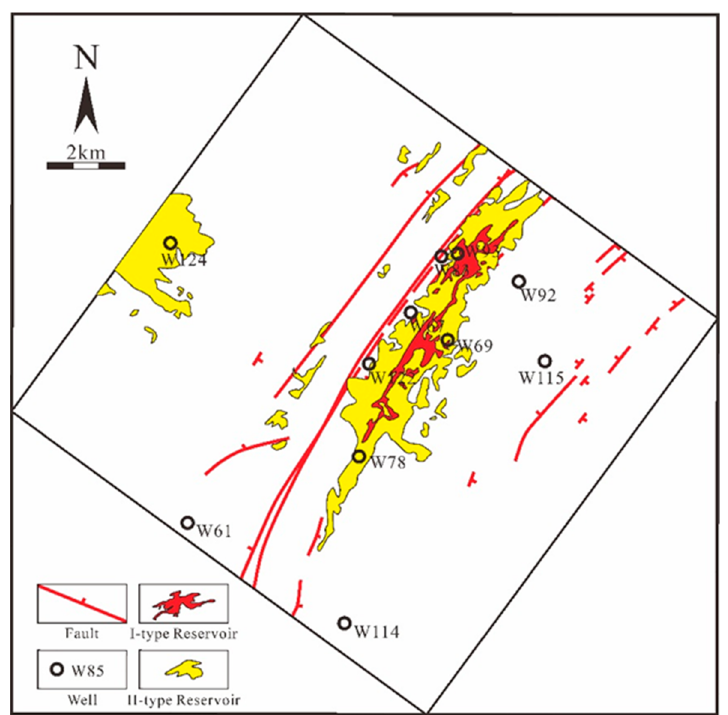
Figure 16. Plane prediction of the hydrothermal dolomite paleokarst reservoir of Maokou Formation in Wolonghe gas field.